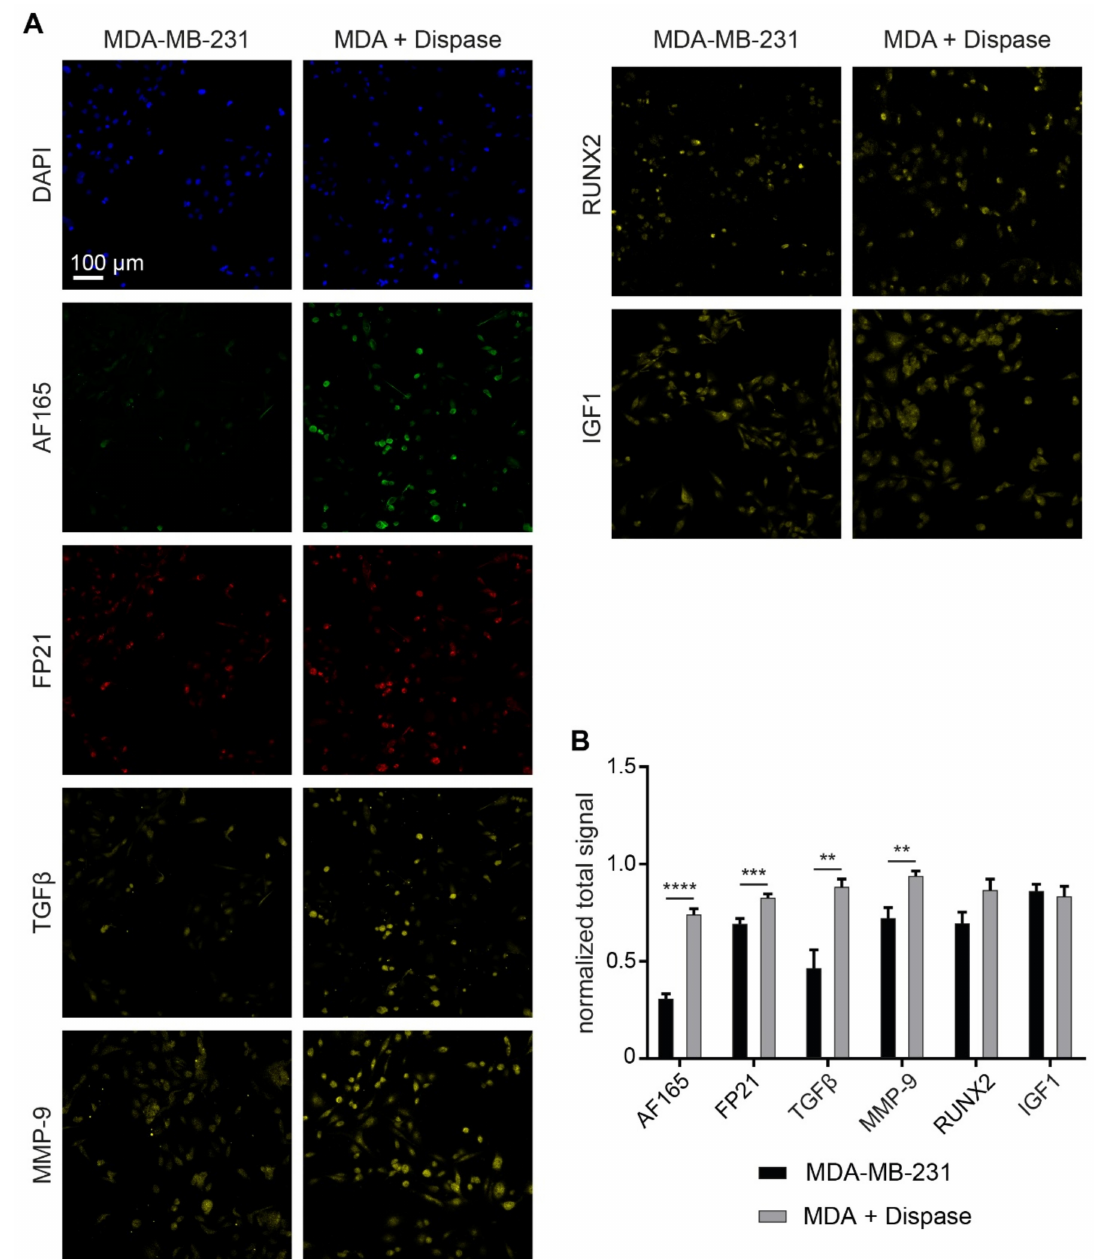
Figure 5. Immunofluorescence signals of regulatory markers are consistent with induced BSP expression. 1,200,000 MDA- MB-231 cells were seeded in Petri dishes containing glass cover slips. After 4 d, cultures were treated with dispase for 6 min. PFA fixed samples were permeabilized and then stained for DAPI, BSP (AF165 and FP21), and one additional regulatory marker (TGF β , MMP-9, RUNX2 or IGF1). ( A ) Representative confocal images in sum projections. ( B ) Graph showing quantitative analysis of fluorescence intensity per cell. Mean + SEM ( n = 6 for TGB β , MMP-9, RUNX2, IGF1; n = 24 for AF165, FP21; ** p < 0.01, *** p < 0.001, **** p <